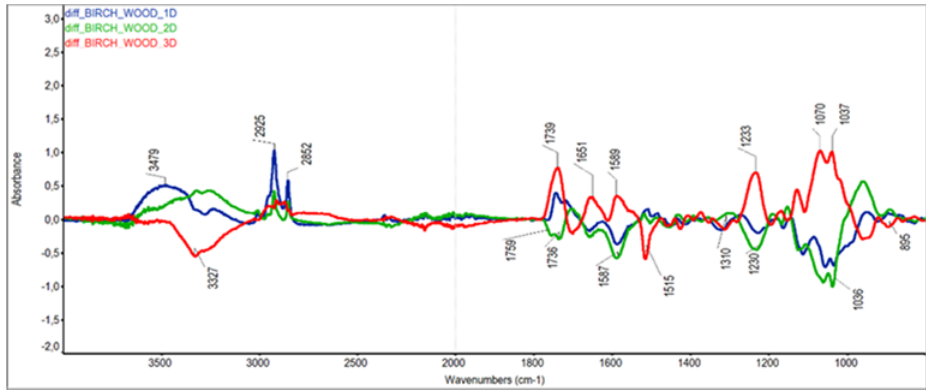
Figure 8. The absorption difference spectra of birch wood.